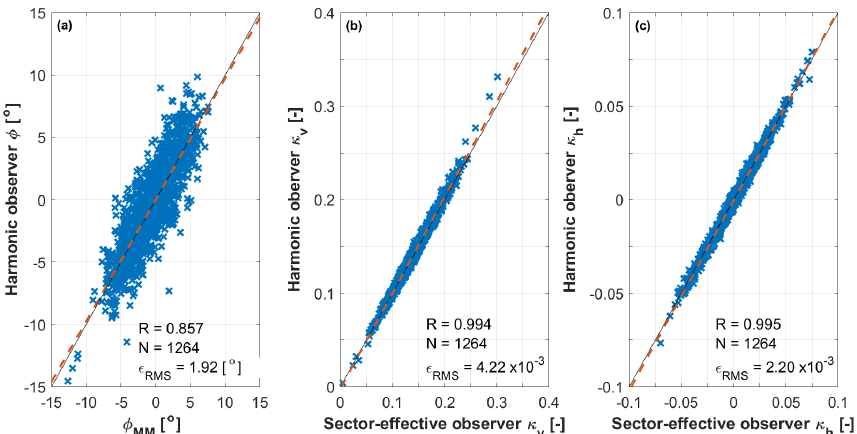
Figure 7. Correlation of 10min averages between estimated parameters ( y axis) and their reference quantities ( x axis) for V ≥ 8ms − 1 . Yaw misalignment angle (a) ; vertical linear shear (b) ; horizontal linear shear (c) . Dashed red line: linear best fit; dashed black line: ideal match; R : Pearson’s correlation coefficient; N : number of data points; (cid:15) RMS : root mean square error.